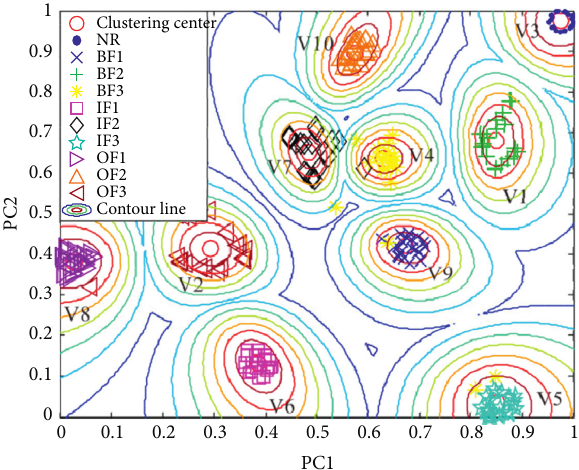
Figure 7: The change of PBMF with cluster number c